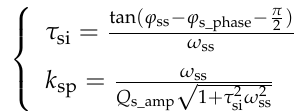
The Bode plots of open-loop and closed-loop transfer functions are shown in Figure 15. The cut-off frequency of the speed open-loop transfer function is 100 Hz, and the phase margin is 30 ◦ . The closed-loop transfer function has a good following characteristic in the bandwidth of 40 Hz. The unit step response of the speed closed-loop transfer function is shown in Figure 16; the rise time is only 2 ms, the overshoot is little, and no steady-state error